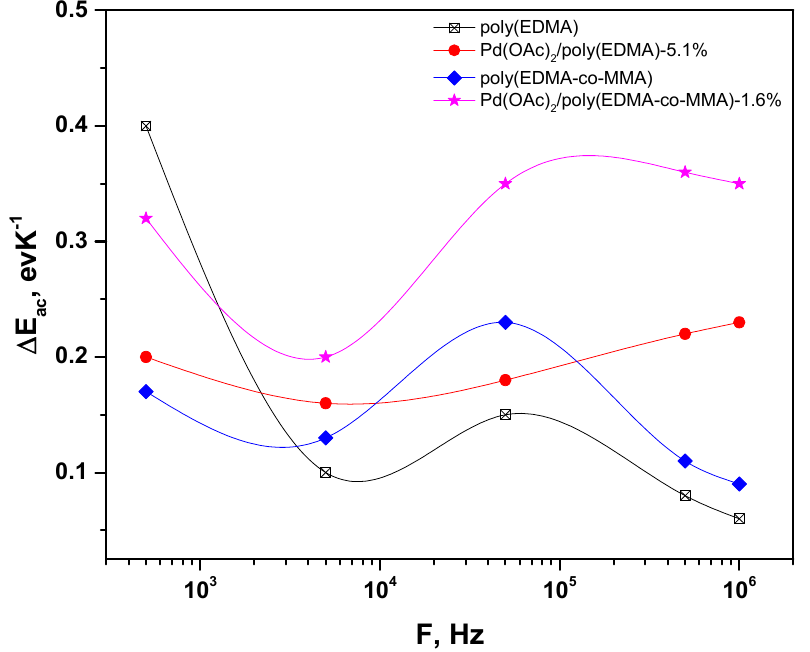
Figure 7. Dependence of ∆Eac on the frequency for ( A ) poly(EDMA), ( B ) Pd(OAc) 2 /poly(EDMA)-5.1%, ( C ) poly(EDMA-co-MMA), and ( D ) Pd(OAc) 2 /poly(EDMA-co-MMA)-1.6%.